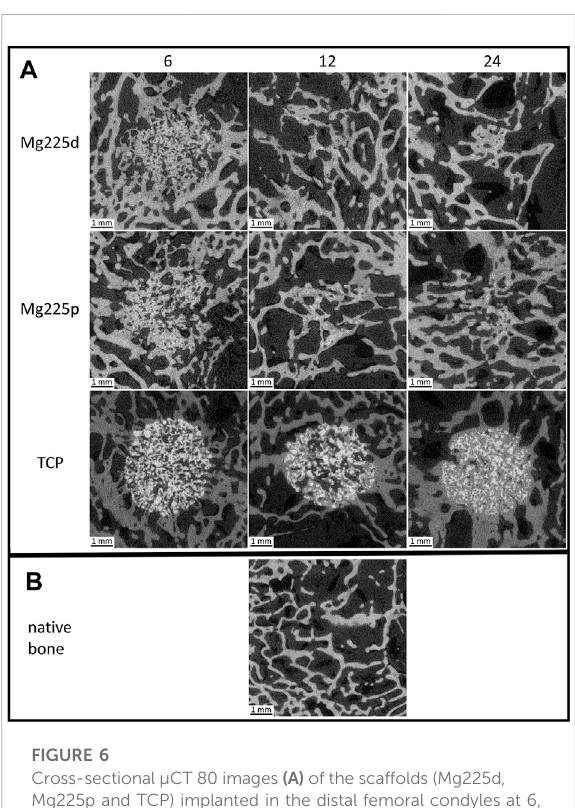
FIGURE 6 Cross-sectional µCT 80 images (A) of the scaffolds (Mg225d, Mg225p and TCP) implanted in the distal femoral condyles at 6, 12 and 24 weeks after surgery (B) compared to native cancellous bone of the lateral femoral